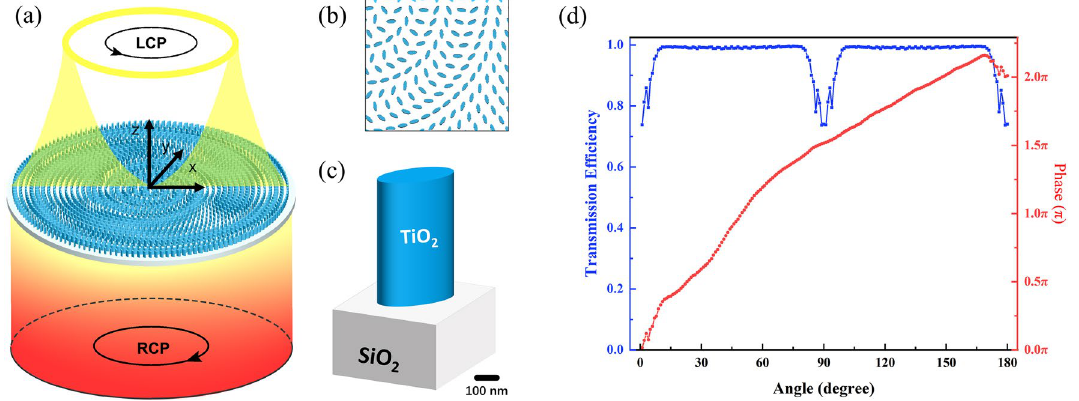
Figure 1. The metasurface design for generating Q-PV. ( a ) The schematic for generating Q-PV by PB phase metasurface. ( b ) The enlarged local part of the PB phase metasurface. ( c ) The structure of each nano-elliptic unit in one period. ( d ) The distribution of the transmission efficiency and the phase delay in the case of the angle between the long axis of the nanopost and the positive half-axis of the x -axis are 0 to 180 (degree).